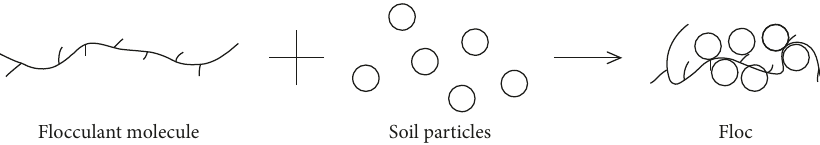
Figure 3: Illustration of the function of flocculants (adapted from Table 1: Properties of the testing soil.